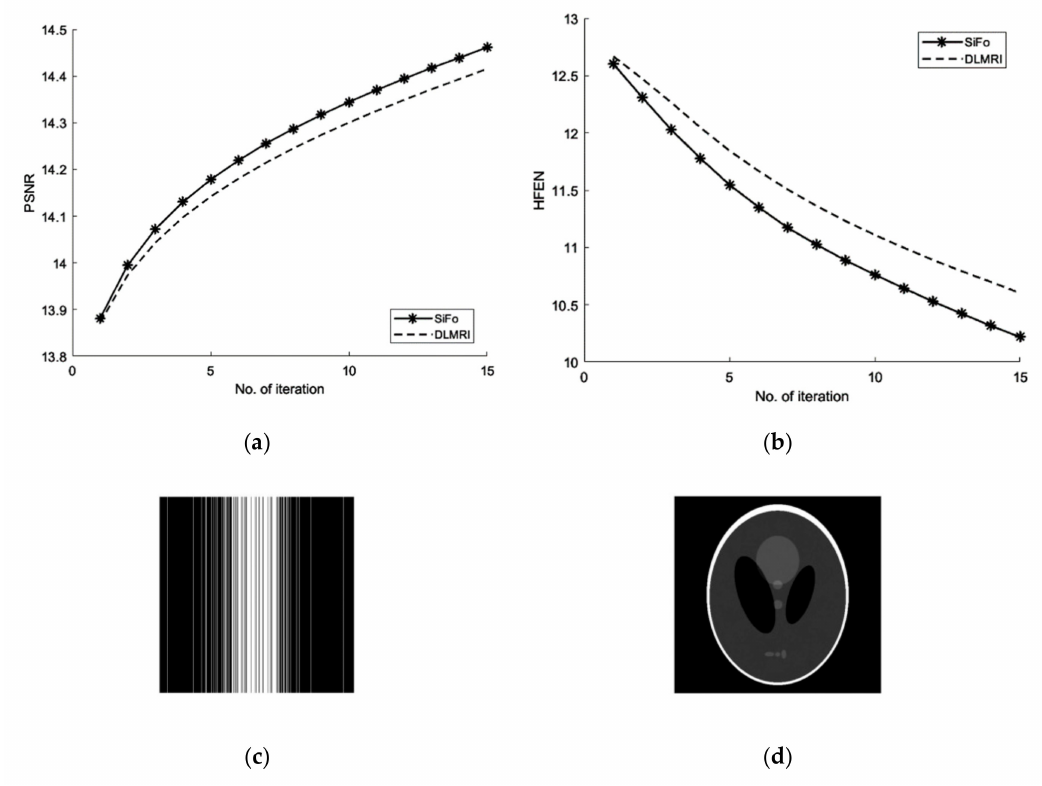
Figure 5. Algorithms performance in noisy case with cartesian sampling. ( a ) PSNR vs iterations with comparison to DLMRI for a phantom image ( b ) HFEN vs iterations with comparison to DLMRI for a phantom image ( c ) Cartesian sampling scheme with 4 fold. ( d ) Recovered